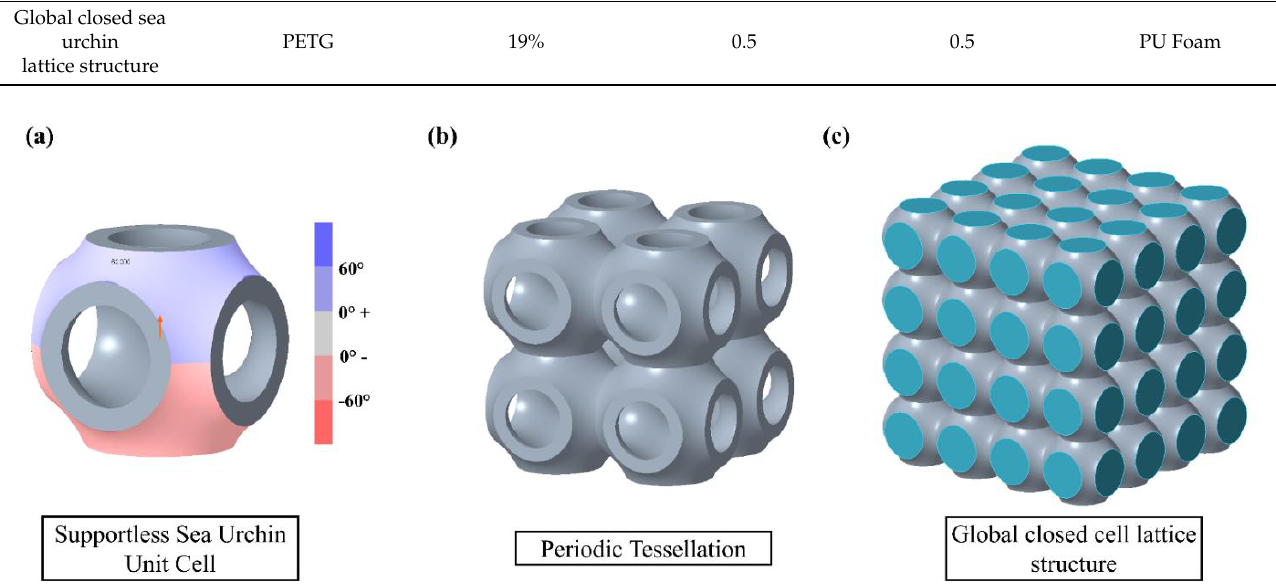
Figure 2. ( a ) Draft analysis of supportless SU unit cell design. ( b ) Periodic tessellation of open cells. ( c ) Global closed cell lattice structure.